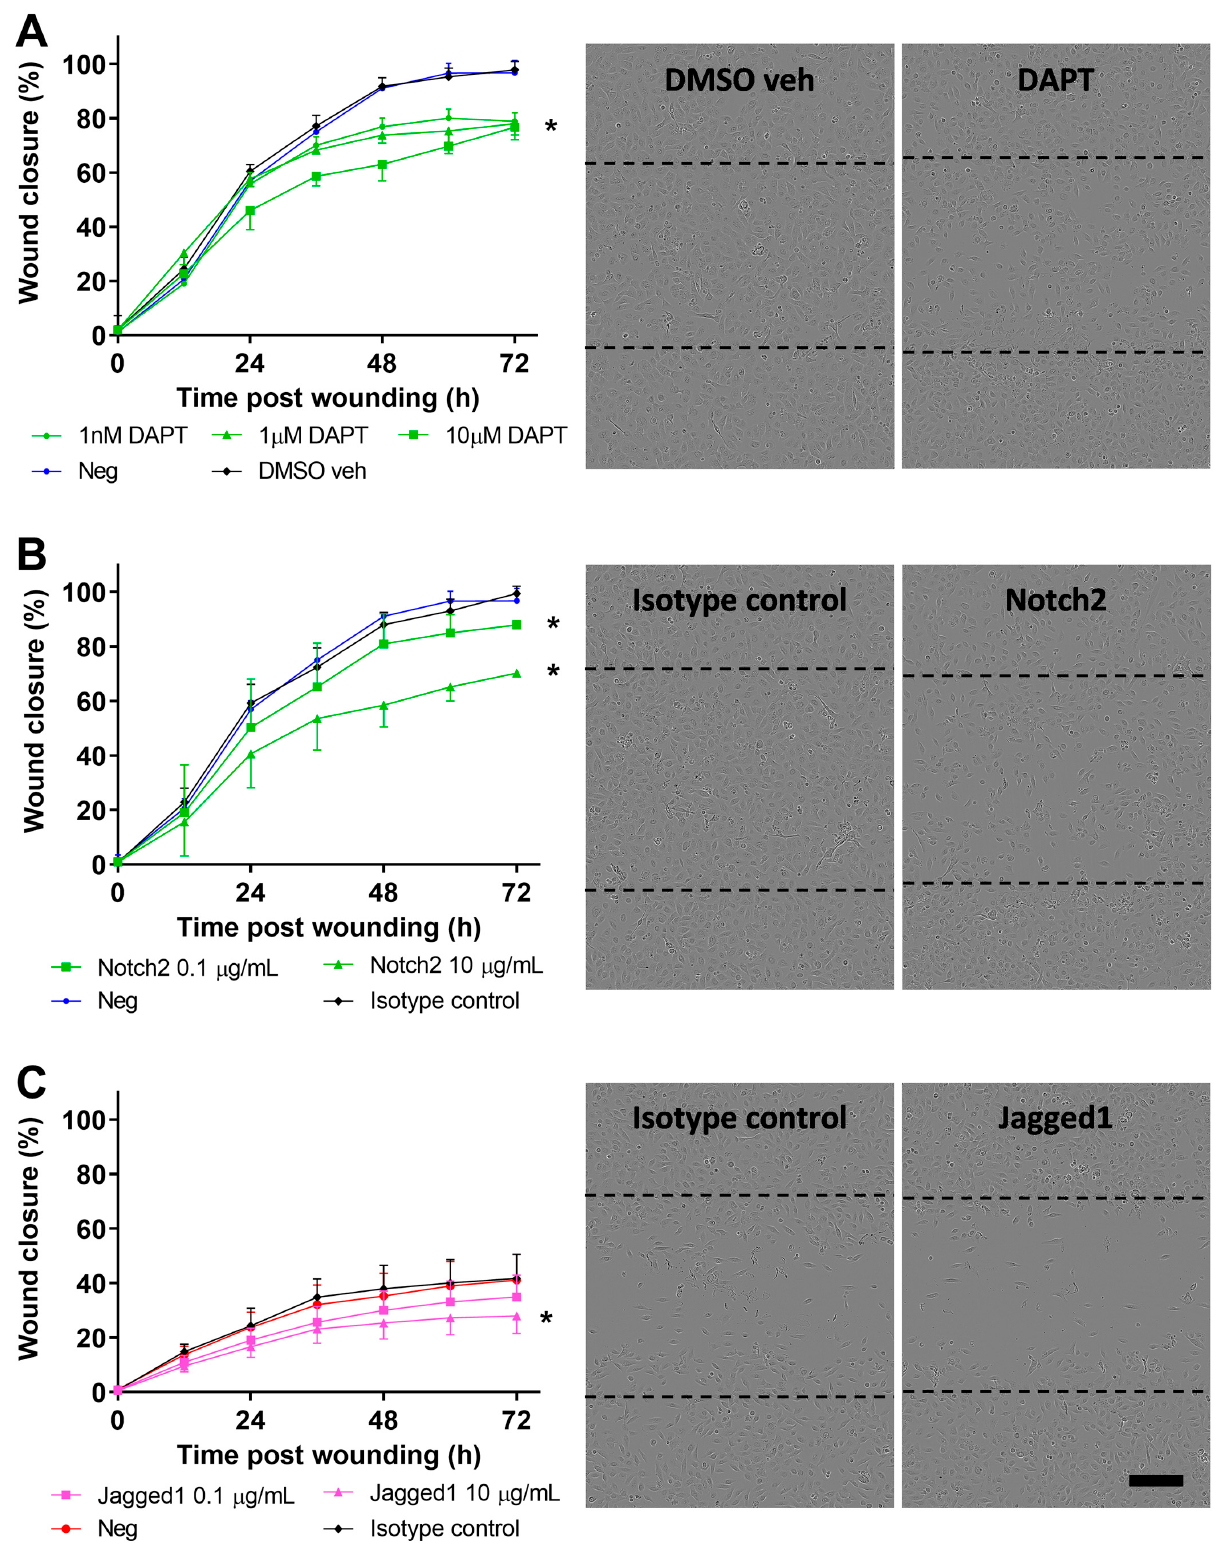
Figure 5. Blocking of Notch signaling in pAEC of children without wheeze. ( A ) Monolayer pAEC cultures from children without wheeze were treated with increasing concentrations (1 nM–10 µ M; green circles, triangles, squares) of the GSI, DAPT 24 h prior to wounding. Wound closure rates of pAEC from children without wheeze treated with DAPT, DMSO vehicle (black diamonds) (0.1% v / v ) or untreated negative control (blue circles) were determined. Full wound closure in DMSO vehicle and untreated negative controls were achieved by approximately 54 h post-wounding. Cultures treated